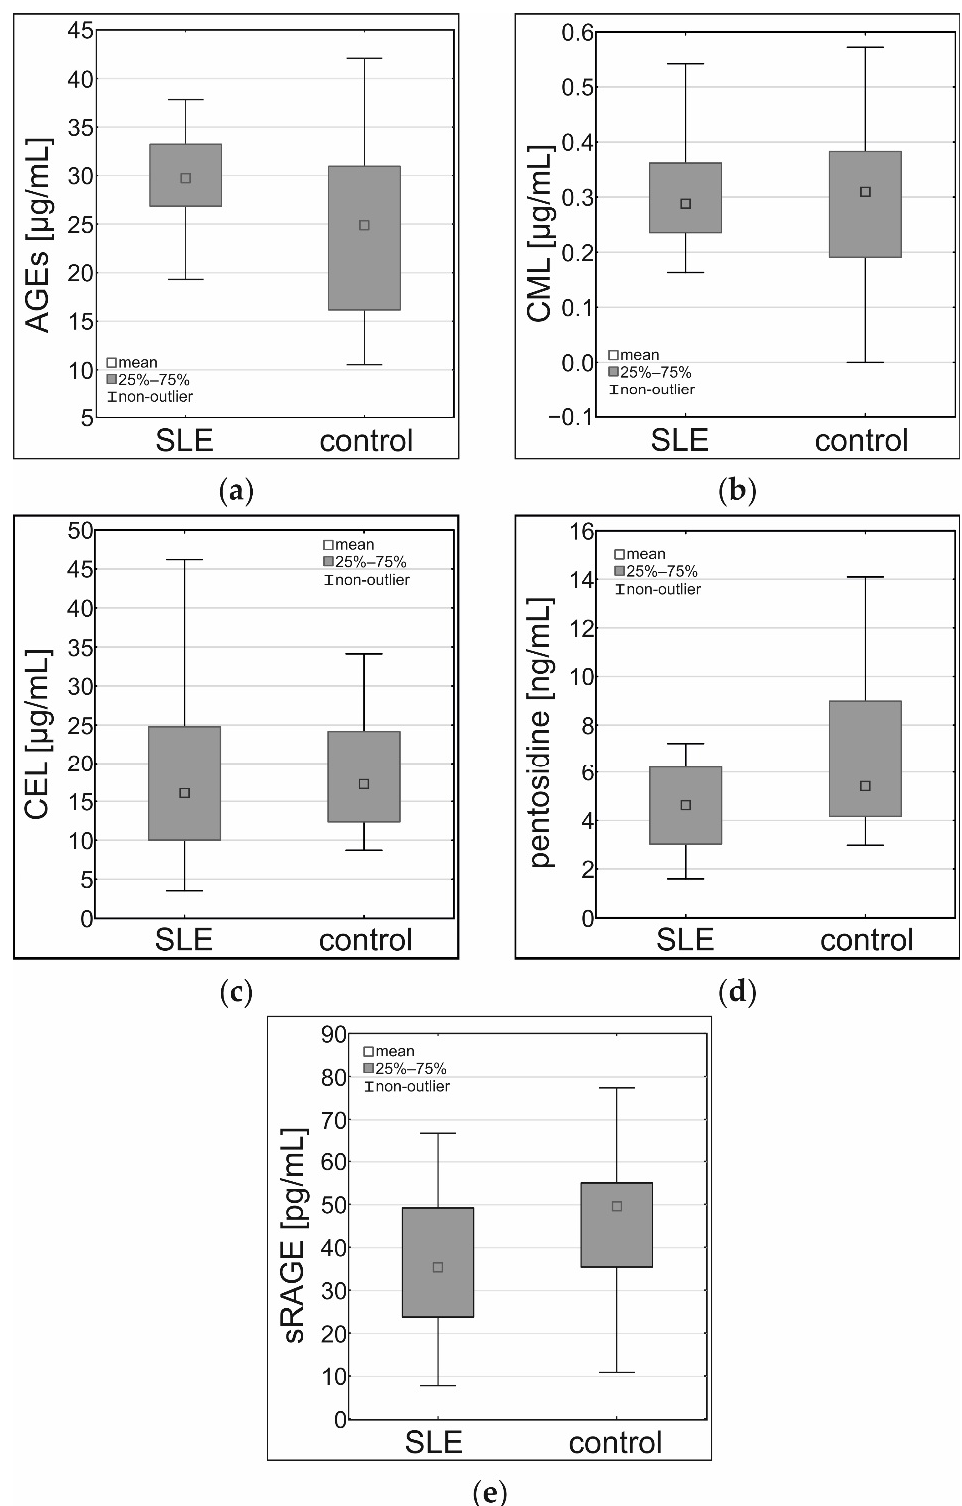
Figure 1. Results of the ELISA assay in the serum samples of the SLE patients and the control group: ( a ) concentrations of AGEs ( µ g/mL), ( b ) concentrations of CML ( µ g/mL), ( c ) concentrations of CEL ( µ g/mL), ( d ) concentrations of pentosidine (ng/mL), ( e ) concentrations of sRAGE (pg/mL).